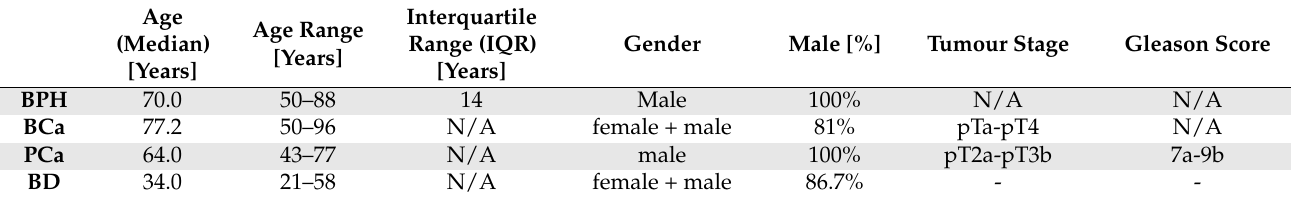
Table 2. Patients and blood donor cohort